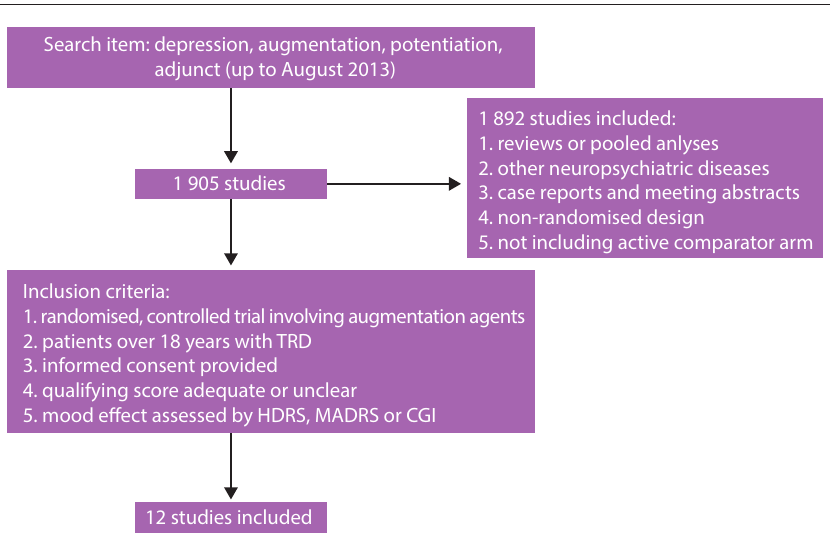
Fig. 1. Literature research. (TRD = treatment-resistant depression; HDRS = Hamilton Depression Rating Scale; MADRS = Montgomery-Asberg Depression Scale; CGI = Clinical Global Impression.)